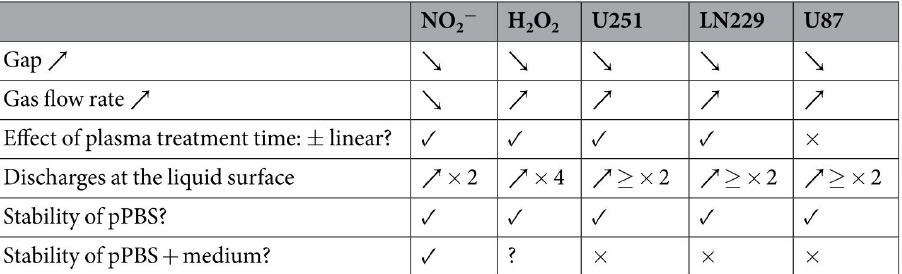
12 of 20 Figure 11. Cysteine and methionine mainly cause the degradation of PTS (cell culture medium) at